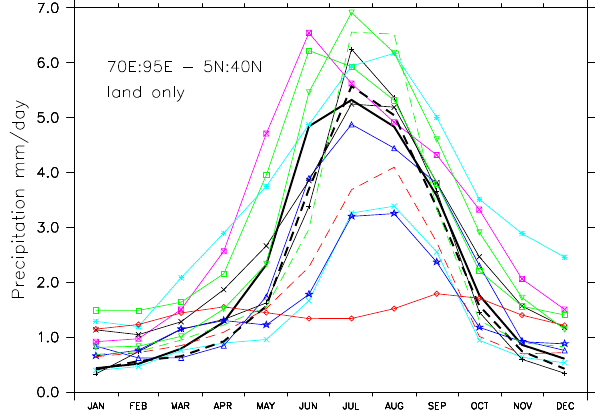
Fig. 4. Insolation difference Mid-Holocene (MH) minus Pre- Industrial (PI) in W/m 2 , calculated using the equations of Berger (1978).